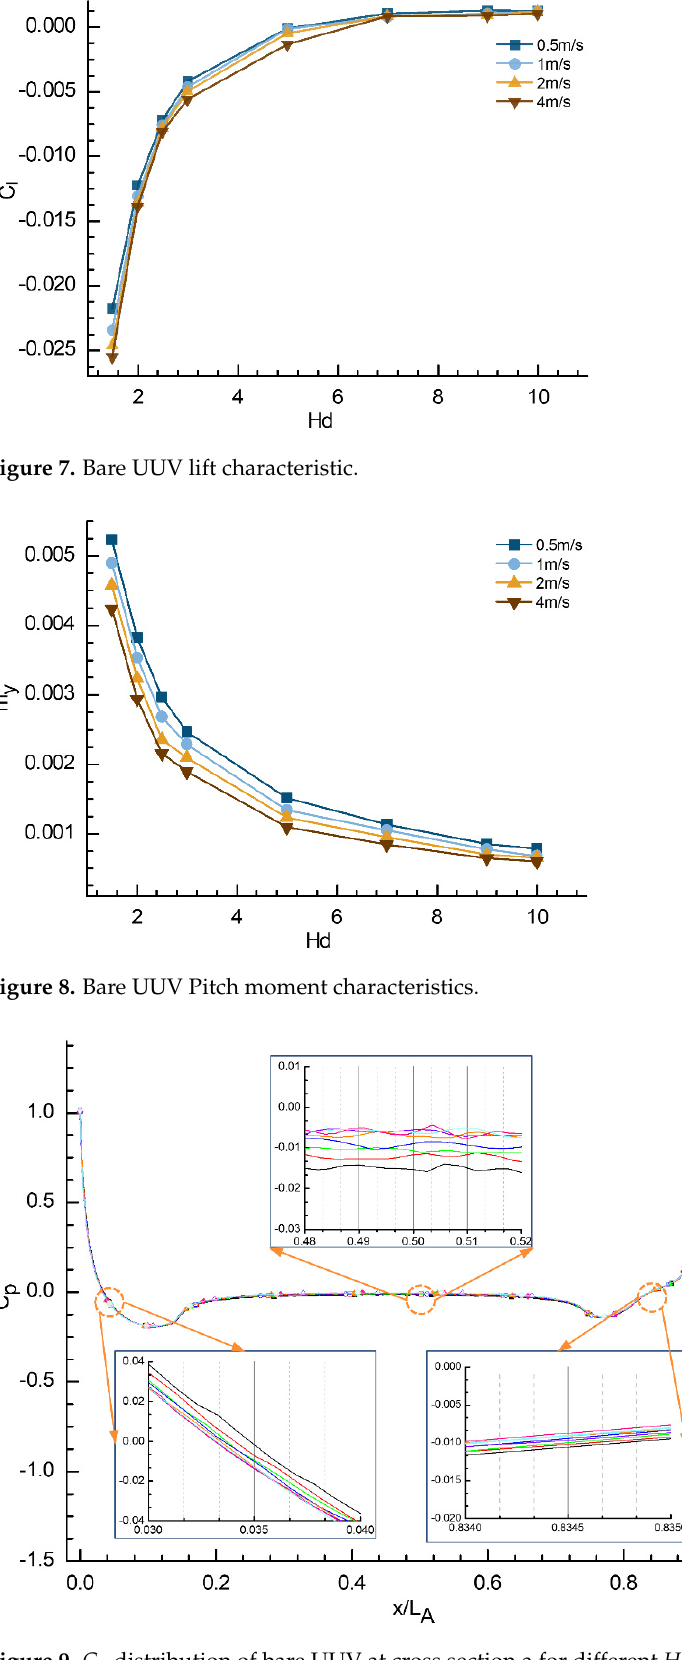
Figure 9. (cid:1829) (cid:1868) distribution of bare UUV at cross section a for different Hd.